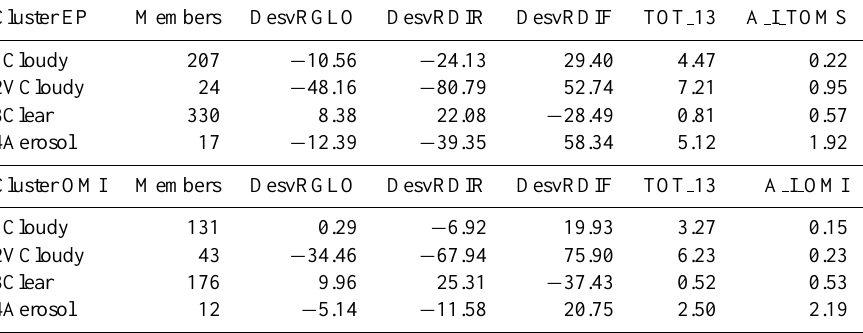
Table 1. Centroid values for Clusters derived relative deviations from the average value in summer months (in percentage) from solar global, direct and diffuse irradiances, cloudiness at 13h TMG in oktas and Aerosol Index from TOMS and